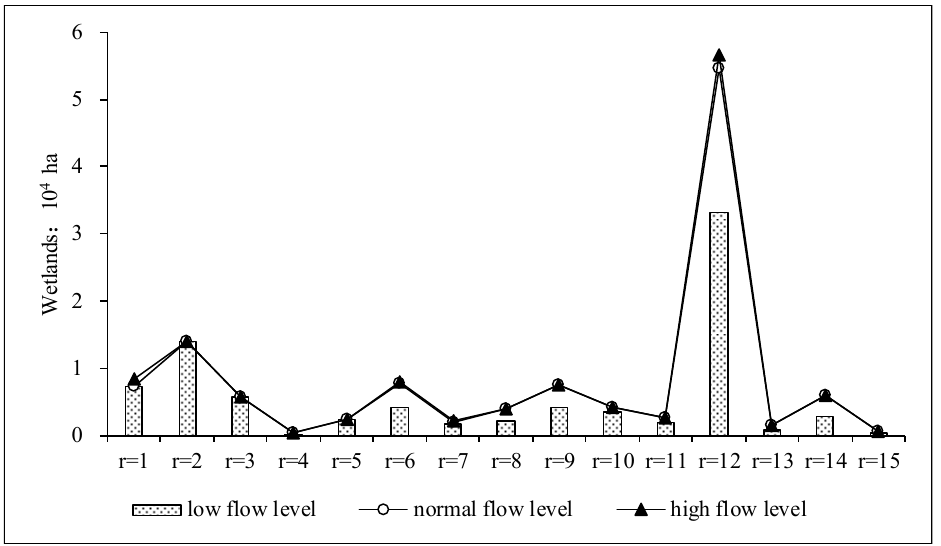
Figure 13. Sizes of restored wetland area based on model 2 in western Jilin Province under different scenarios.